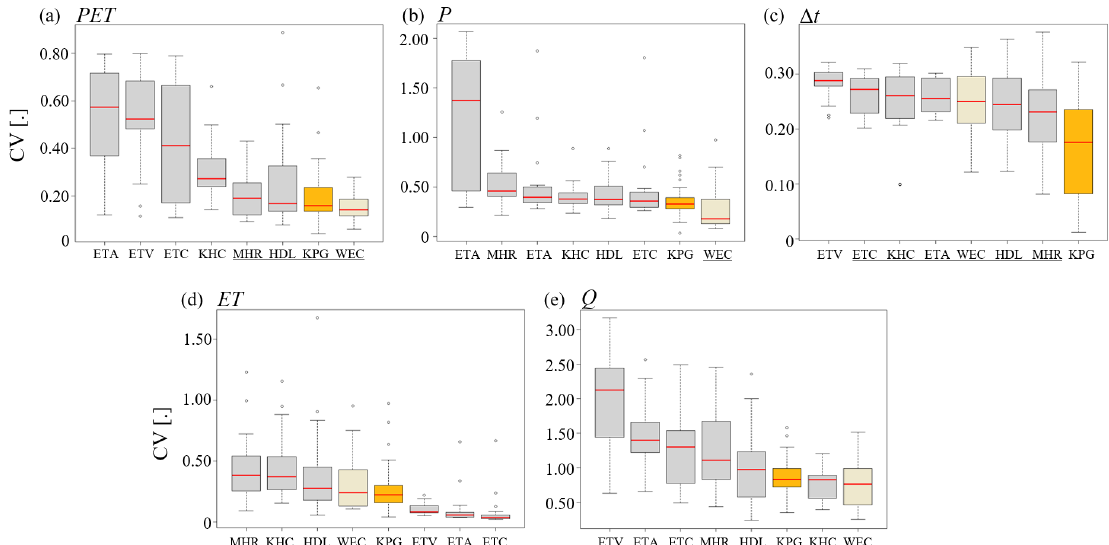
Figure 3. Boxplots of coherence, quantified as intra-zone CV for hydroclimate variables of interest (a–e) , for each assessed climate classifi- cation system. In each panel, KPG is shown in gold and WEC in light beige. The K–S test was used to determine whether the distributions were different from WEC. Systems whose coherence distributions were not statistically different from that of WEC are underlined.